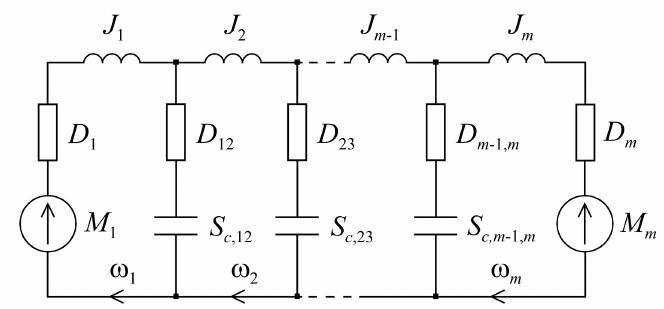
Figure 2. Equivalent circuit corresponding with the kinematic structure depicted in Figure 1.